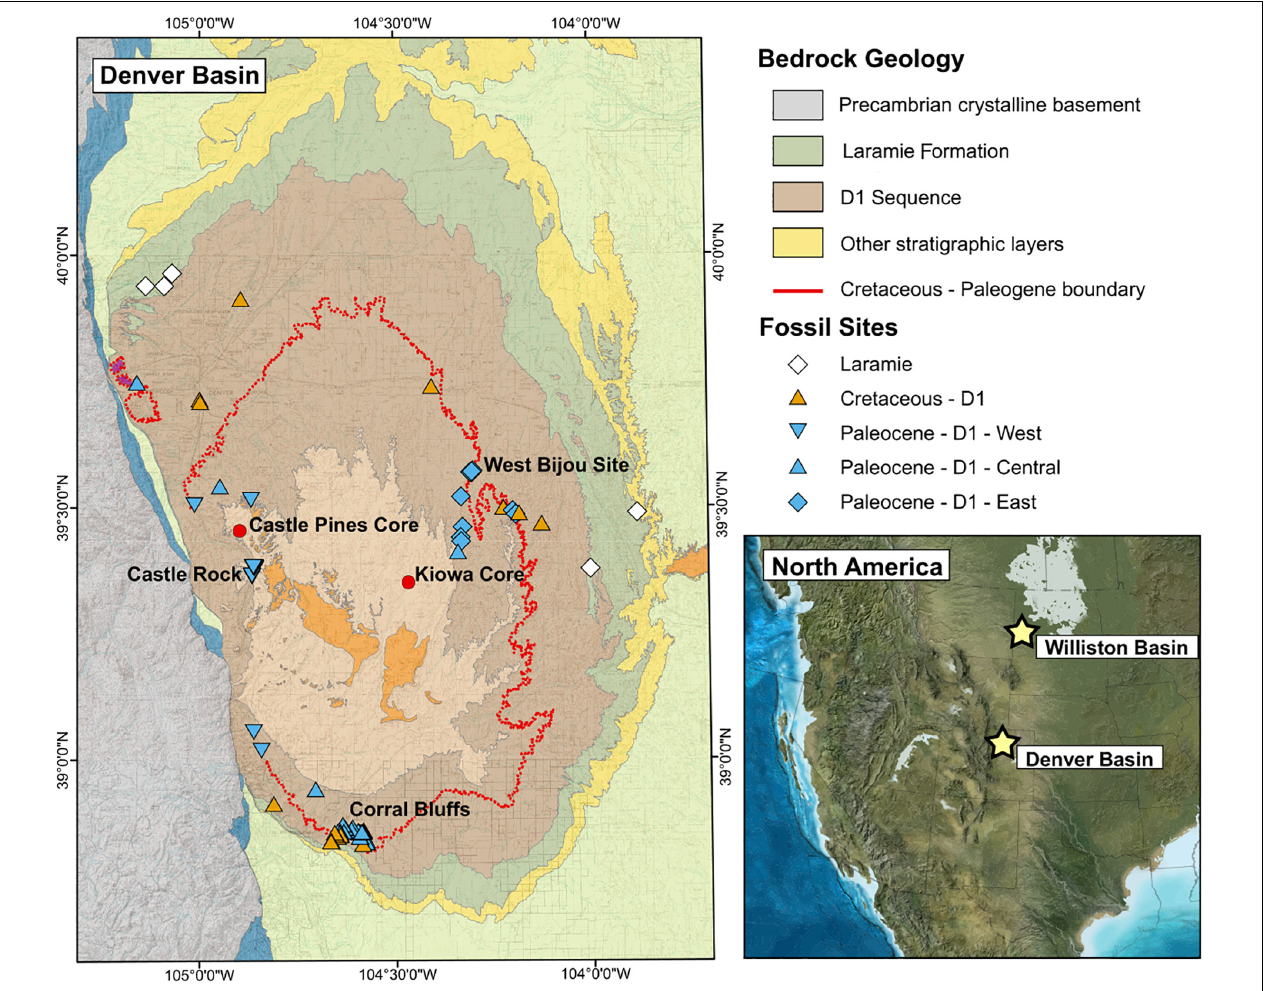
FIGURE 1 | Bedrock geology of the Denver Basin (modified from Dechesne et al., 2011) and locations of megafloral fossil sites. The D1 Sequence in yellow and the Laramie Formation in pink are the two fossil-bearing sediments considered in this study. The inset map [Paleogeography of the North America Western Interior at the KPB, from Ron Blakely, Colorado Plateau Geosystems, Arizona, United States (http://cpgeosystems.com/paleomaps.html)] shows the relative position of the Williston and Denver Basins; the stars are in the general region of the fossil sites used from each basin.